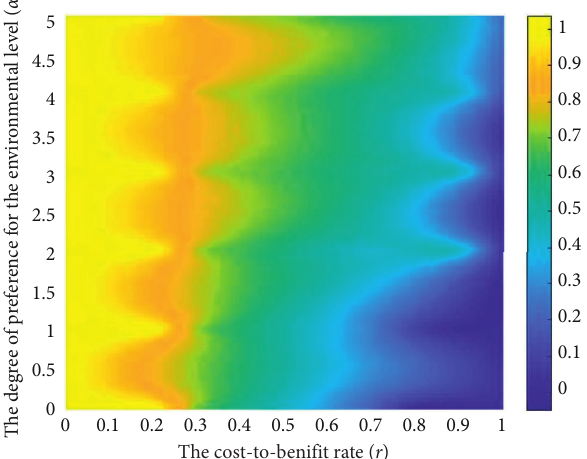
Figure 10: The colour-coded (see the bar on the right) density of cooperation ρ c on the α − r parameter plane. The depicted are obtained in the SDG for u � 0.2. The yellow shading corresponds to the higher stationary density of cooperators at each particular combination of α and r